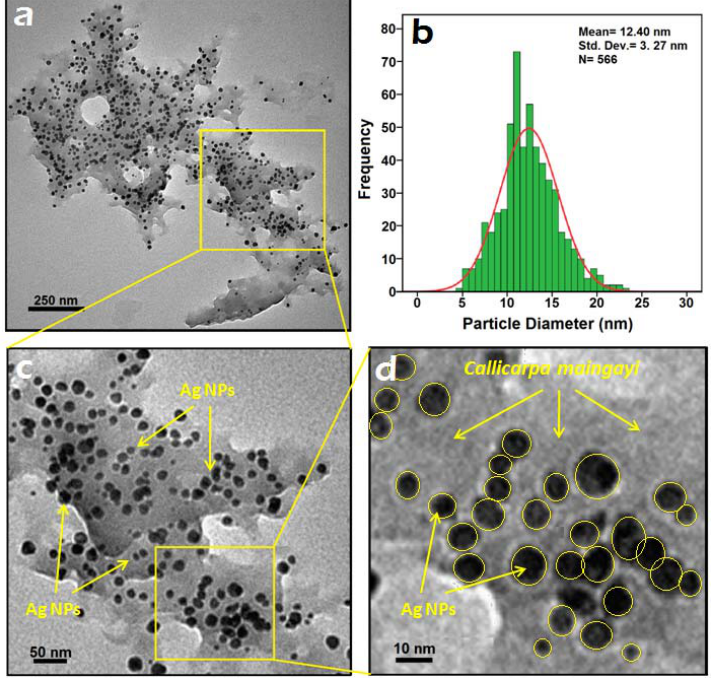
Figure 4. TEM image and corresponding size distribution of Ag/ Callicarpa maingayi after 48 h.